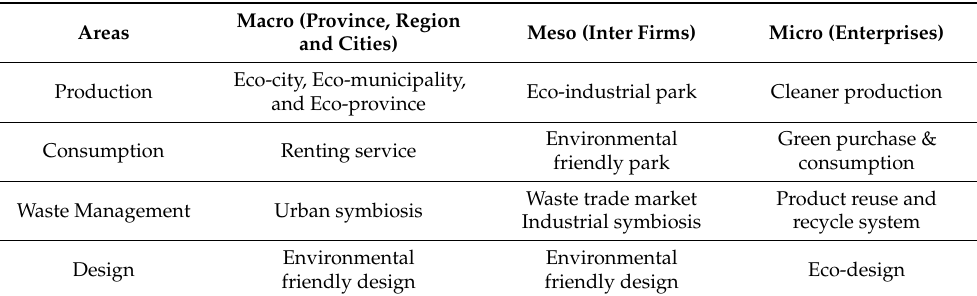
Table 1. Three Levels of Circular Economy (CE) Practices in China (adapted from